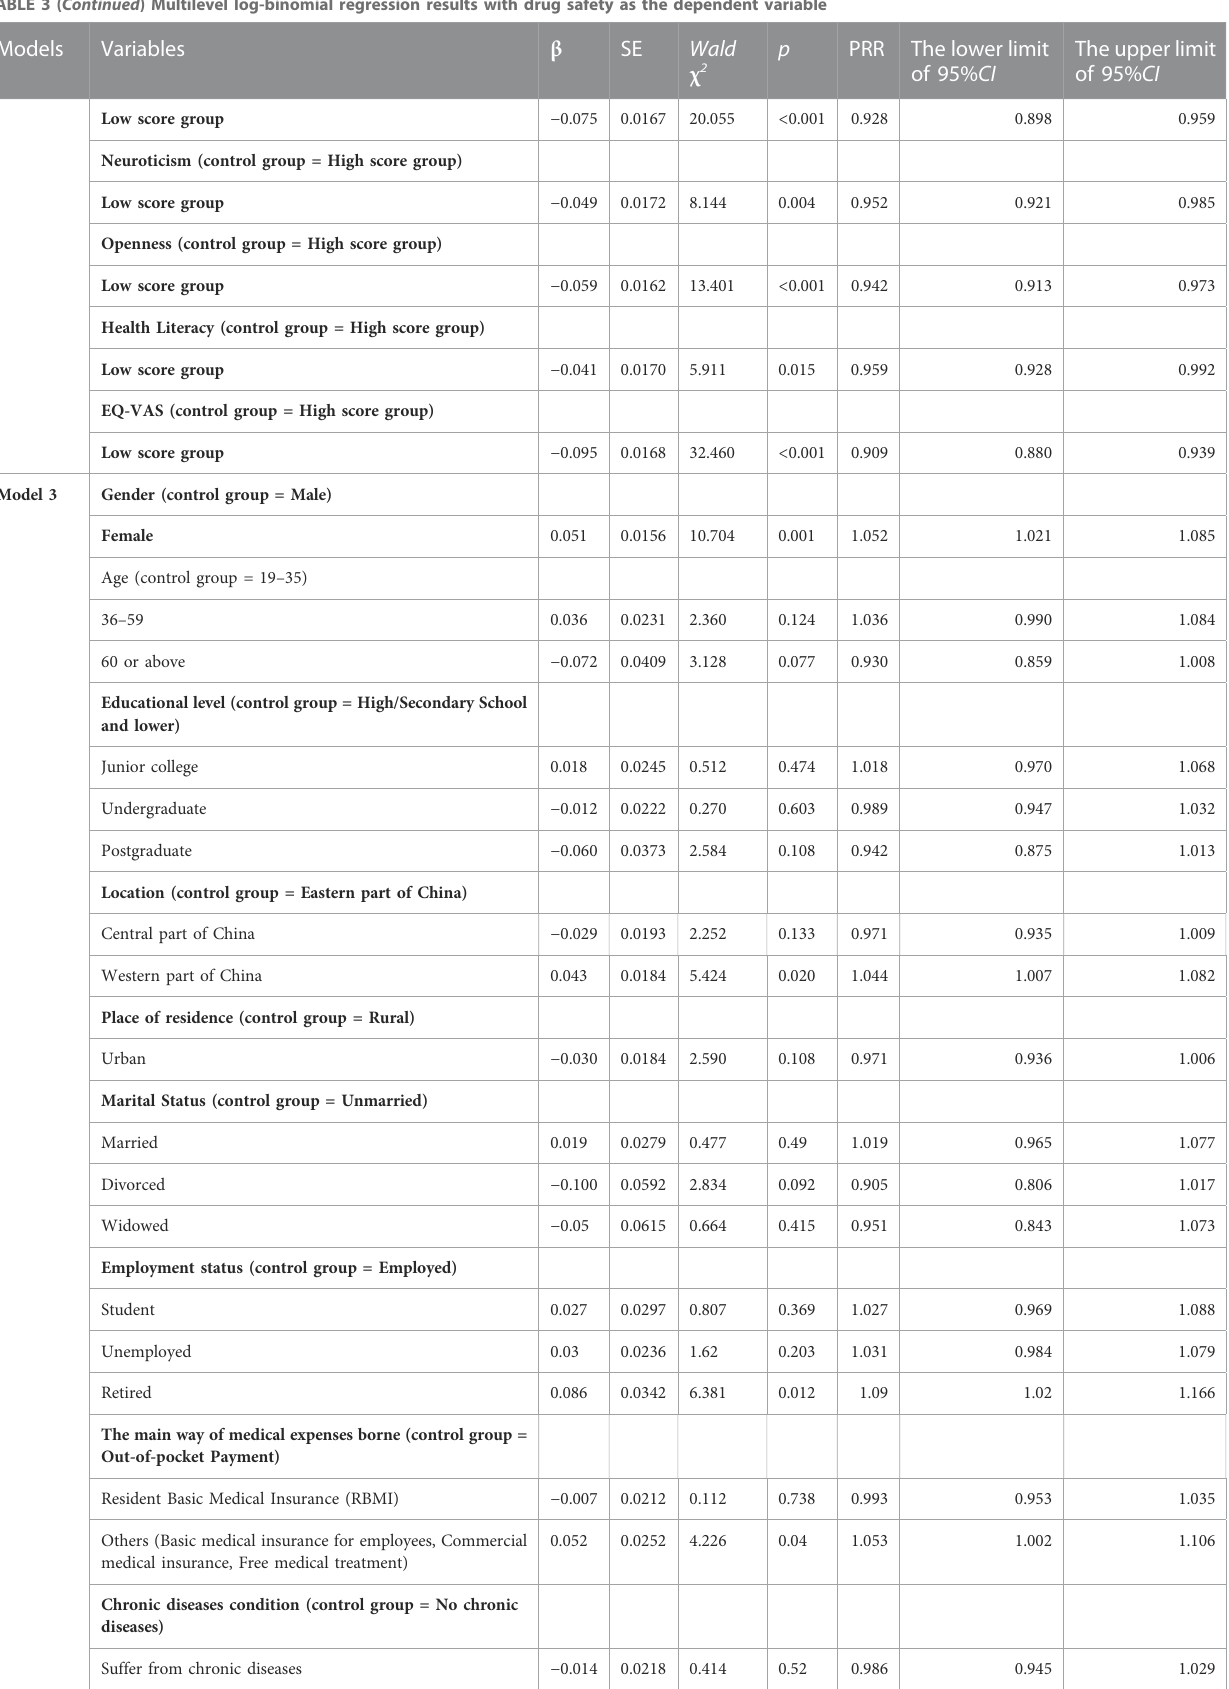
TABLE 3 ( Continued ) Multilevel log-binomial regression results with drug safety as the dependent variable